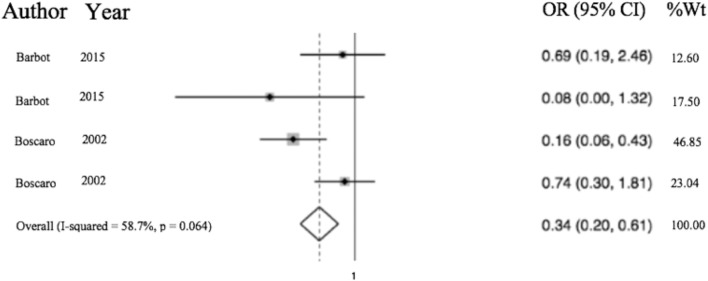
Odds of VTE in CS on anticoagulation significantly less than hip fracture surgery with anticoagulation. Total OR 0.34 (95% CI 0.20–0.61) of postop (within 30 days of surgery) VTE in CS with anticoagulation compared to odds of postoperative VTE in cases of hip fracture repair with anticoagulation. This suggests the odds of VTE in CS patients in the perioperative period for those undergoing adrenalectomy or TSS are 66% less than that of patients undergoing surgery for hip fracture.